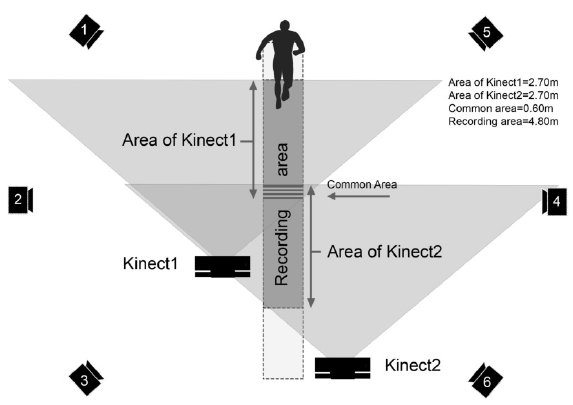
Figure 1. An overview of the workspace; the dual Kinect V2 system and the six Vicon cameras are shown. Each Kinect V2 sensor has a depth range for skeleton tracking of 2.70 meters. An overlapped field of view of 0.60 meters was reserved for the transition between the signals. The final walking path (recording area) had a length of 4.80 meters. More details about this configuration can be found in